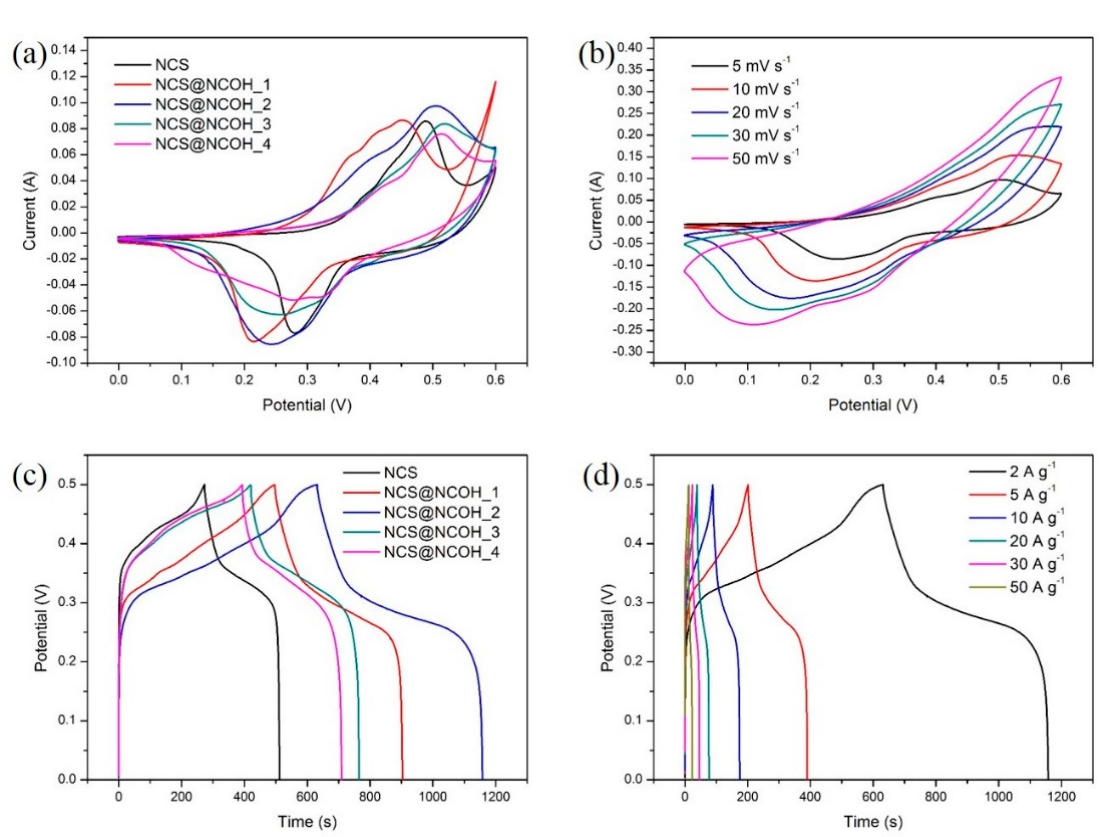
Figure 7. ( a ) CV curves of the NCS nanotube arrays and NCS@NCOH core-shell nanotube arrays with different electrodeposition time at 5 mV s -1 , ( b ) CV curves of NCS@NCOH_2 core-shell nanotube arrays at various scan rates, ( c ) GCD curves of NCS nanotube arrays and NCS@NCOH core-shell nanotube arrays with different electrodeposition times at 2 A g -1 , and ( d ) GCD curves of NCS@NCOH_2 core-shell nanotube arrays at different current densities.